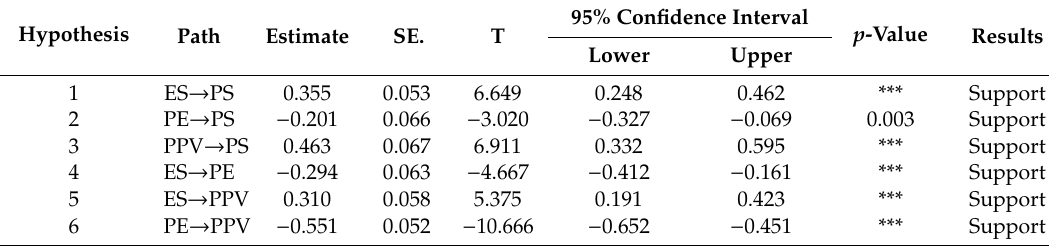
Table 5. Direct e ff ects of the hypothesized model.